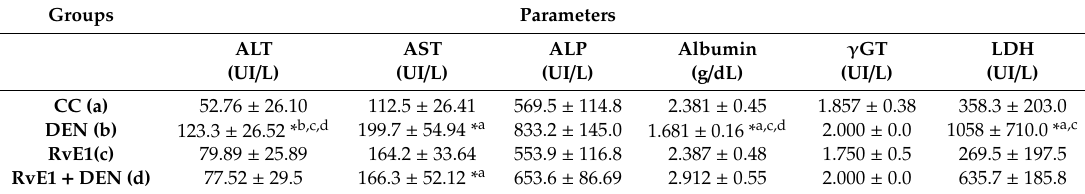
Table 1. Serum clinical values of the Sprague-Dawley rats. Data are expressed as mean ± SD. The * means p < 0.005.